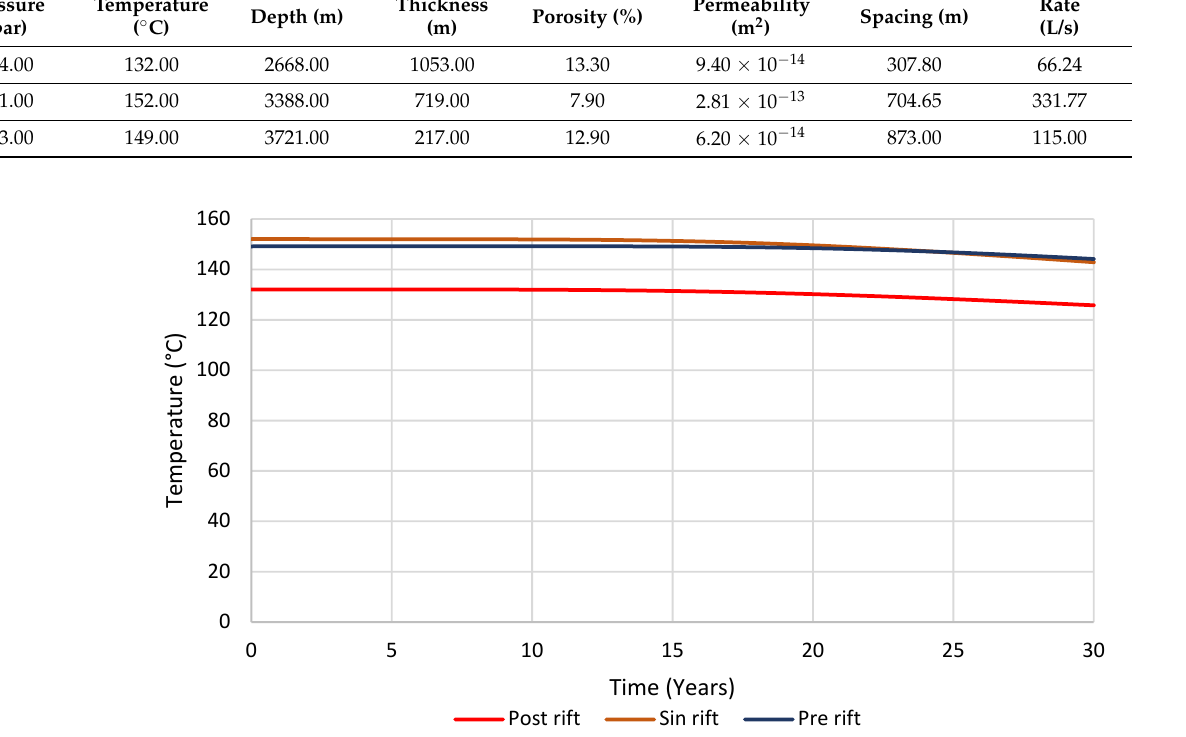
Figure 19. Temperature change around a doublet in the simulation programme.